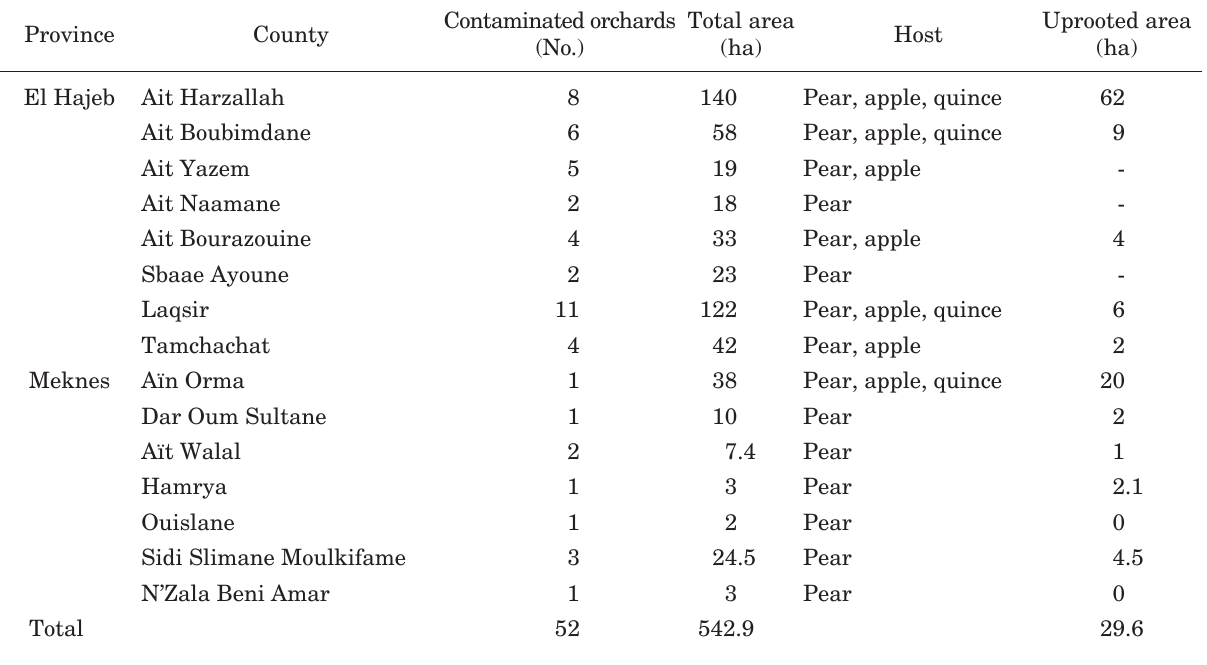
Table 2. Current situation of fi re blight in El Hajeb and Meknes regions in Morocco (Plant Protection Service of Me- knes and El Hajeb, 2009). Province County El Hajeb 8 140.9 5 Pear, apple, quince 62.5